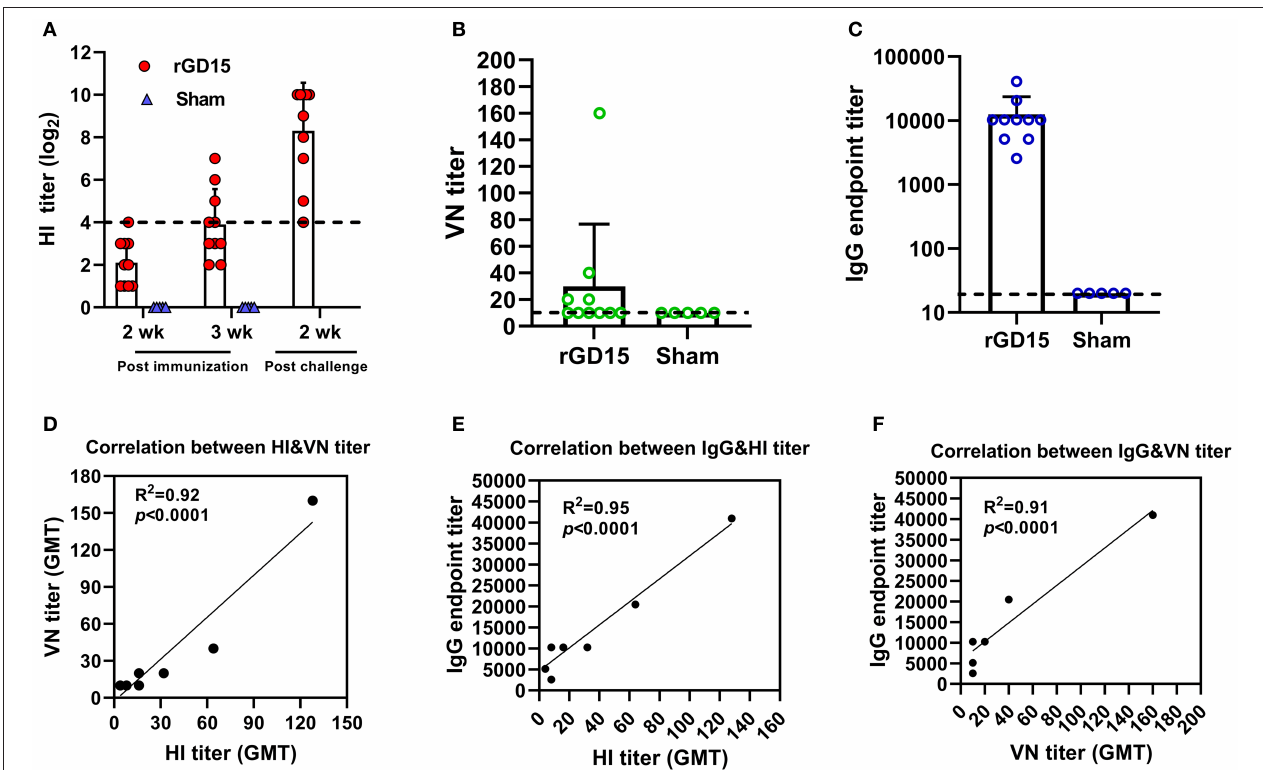
FIGURE 1 | Antibody response induced by inactivated H7N9 vaccine in chickens. (A) HI, (B) VN, and (C) IgG titers induced by the vaccine. (D) Correlation analysis between VN and HI antibody titers. (E) Correlation analysis between IgG and HI antibody titers. (F) Correlation analysis between IgG and VN antibody titers. The dotted line in (A) indicates the cutoff value for positive reading in HI assay (4 log 2 ) and the lines in (B,C) stand for the lower detection limit for serological assays. GMT in (D–F) stands for geometry mean